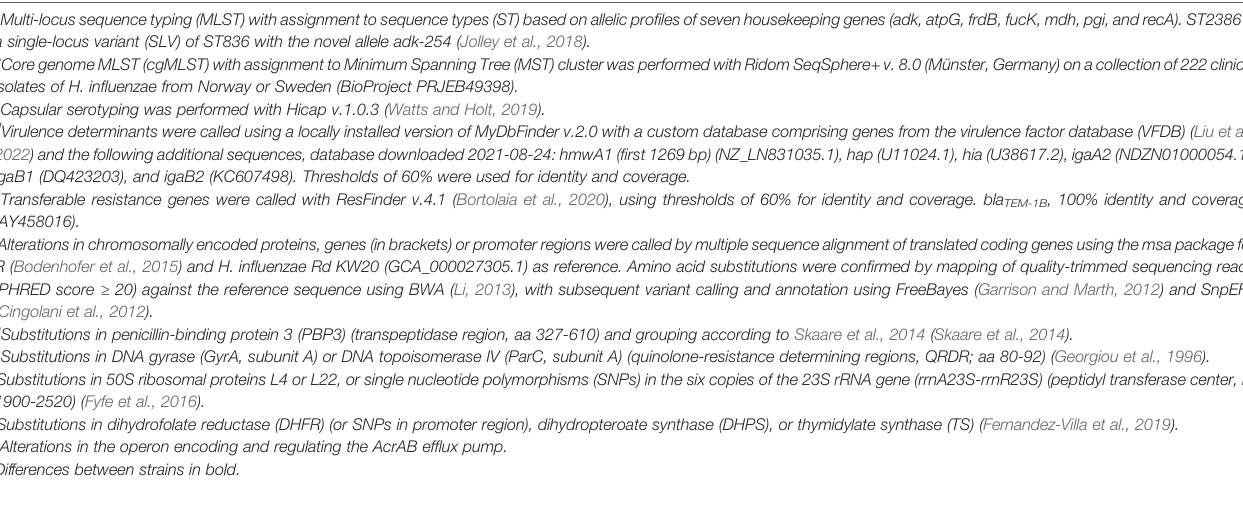
TABLE 1 | Molecular characteristics of Hi-117, Hi-226, and Hi-197.